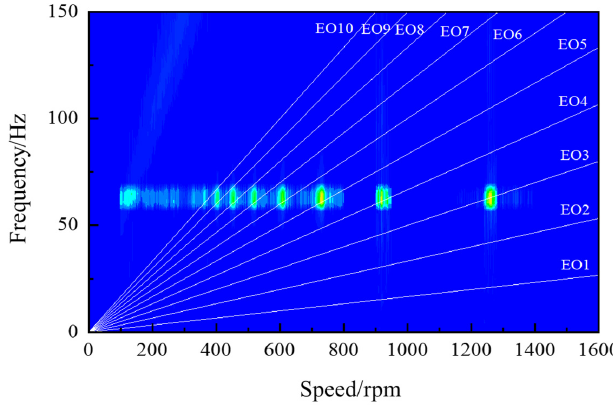
Figure 12. Campbell diagram of variable speed strain signal based on wavelet analysis.